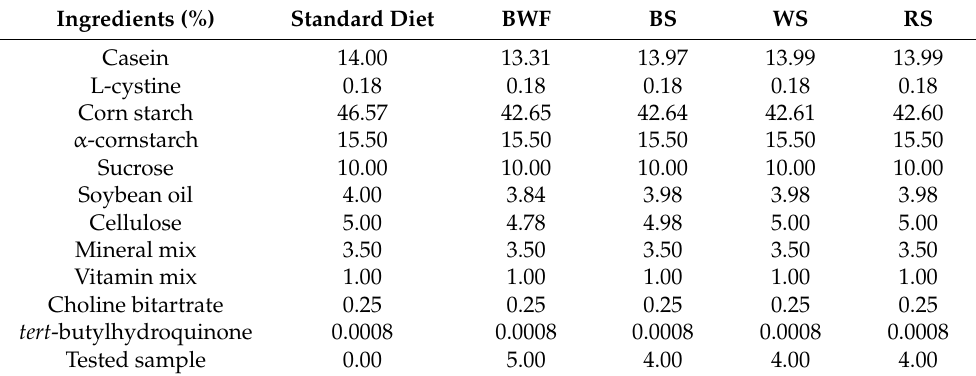
Table 3. Composition of standard and experimental diets used in the Study